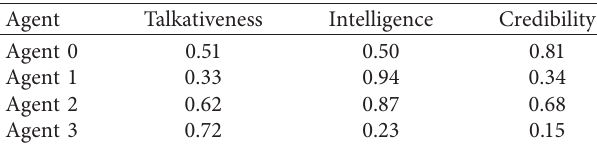
Table 1: Agents’ attributes in a representative 4-agent group. Note that all attributes are normalized in the range of [ 0 , 1 ] .